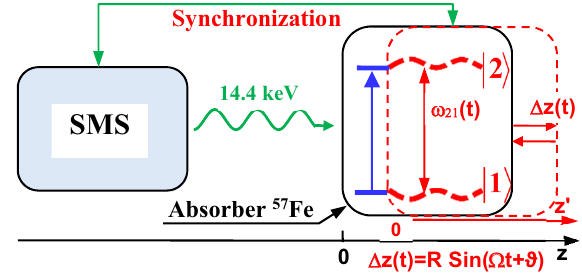
Figure 1. (Color online) Energy scheme of the resonant interaction between 14.4-keV photons and vibrating absorber. Recoilless 14.4-keV photons (λ≈0.86 Å) emitted from SMS (left side) resonantly interact with transition |1> → |2> of 57 Fe nuclei during the propagation through the single-line 57 Fe absorber (right side). They are resonantly absorbed in motionless absorber (blue lines). Harmonic vibration of the absorber as a whole (piston-like vibration) with circular frequency Ω, amplitude R , and initial phase along the photon propagation direction (marked in red) or dual-tone vibration leads to periodic temporal variation in |1> → |2> transition ϑ frequency ω 21 ( t ) (dashed red curves) due to the Doppler effect. The emission of photons can be locked to the initial phase of the absorber vibration, . The axis z labels the laboratory reference frame, red axis z ’ labels the reference frame of the vibrating absorber, and Δ z = z–z ϑ